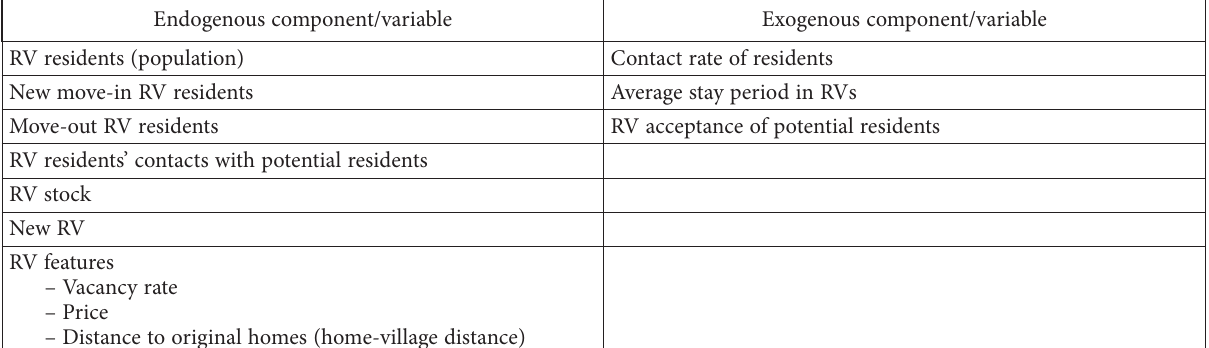
Table 1. Components of the RV industry system